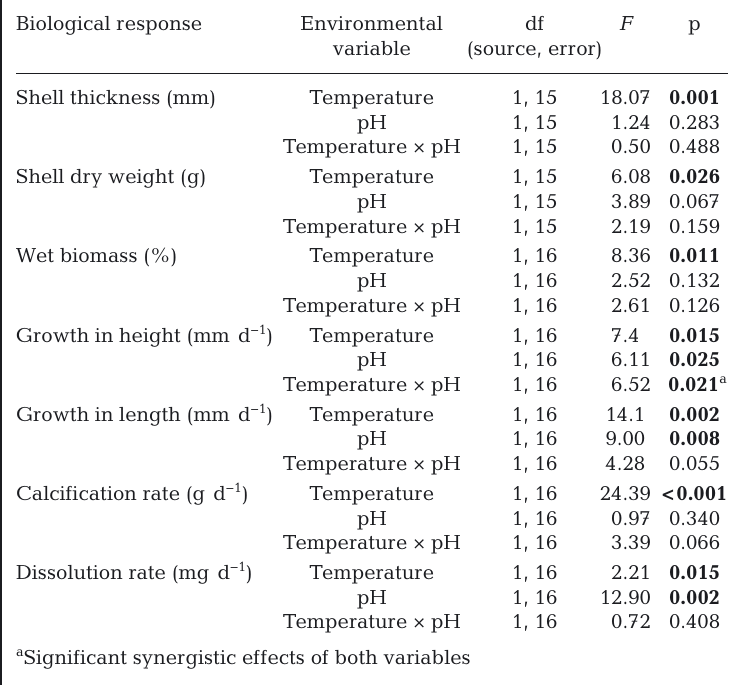
Table 2. Summary results comparing Argopecten purpuratus shell thickness and shell weight (ANCOVA), biomass and growth rates in shell height and length, and calcification and dissolution rates (2-way ANOVA) between combinations of pH (7.7 and 8.0) and temperature (14 and 18°C) used in experimental treatments. Significant p-values (p < 0.05) are shown in bold